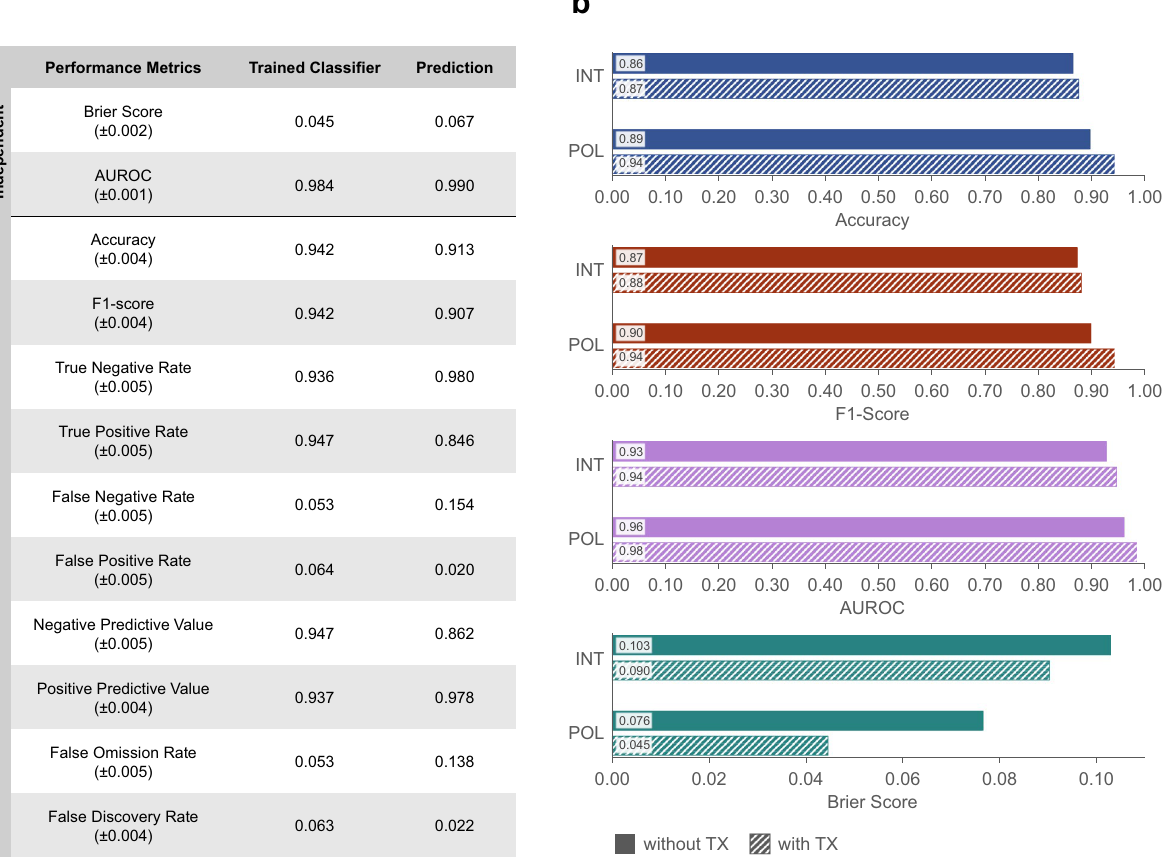
Figure 5. Tissue classification performance. ( a ) Tissue classification and prediction with a binary logistic regression classifier, trained using all polarimetric and texture parameters. Reported values are mean ± standard deviation. ( b ) Testing the impact of various parameters using 4 subsets of the measured parameters, including SHG intensity (INT) and all 5 polarimetric parameters (POL), with and without texture parameters (TX). All groups include pixel density. Differences in accuracy, F1-Score, AUROC, and Brier score between groups are statistically highly significant ( p ≪ 0.001 ), as determined by the Kruskal–Wallis H test and the Dunn– Bonferroni post hoc test. Using all polarimetric and texture parameters improves the classification performance across all metrics. All reported accuracy and F1-score values have < 0.4% standard error, and AUROC and Brier score have standard errors of < 0.2% and < 4.5% ,